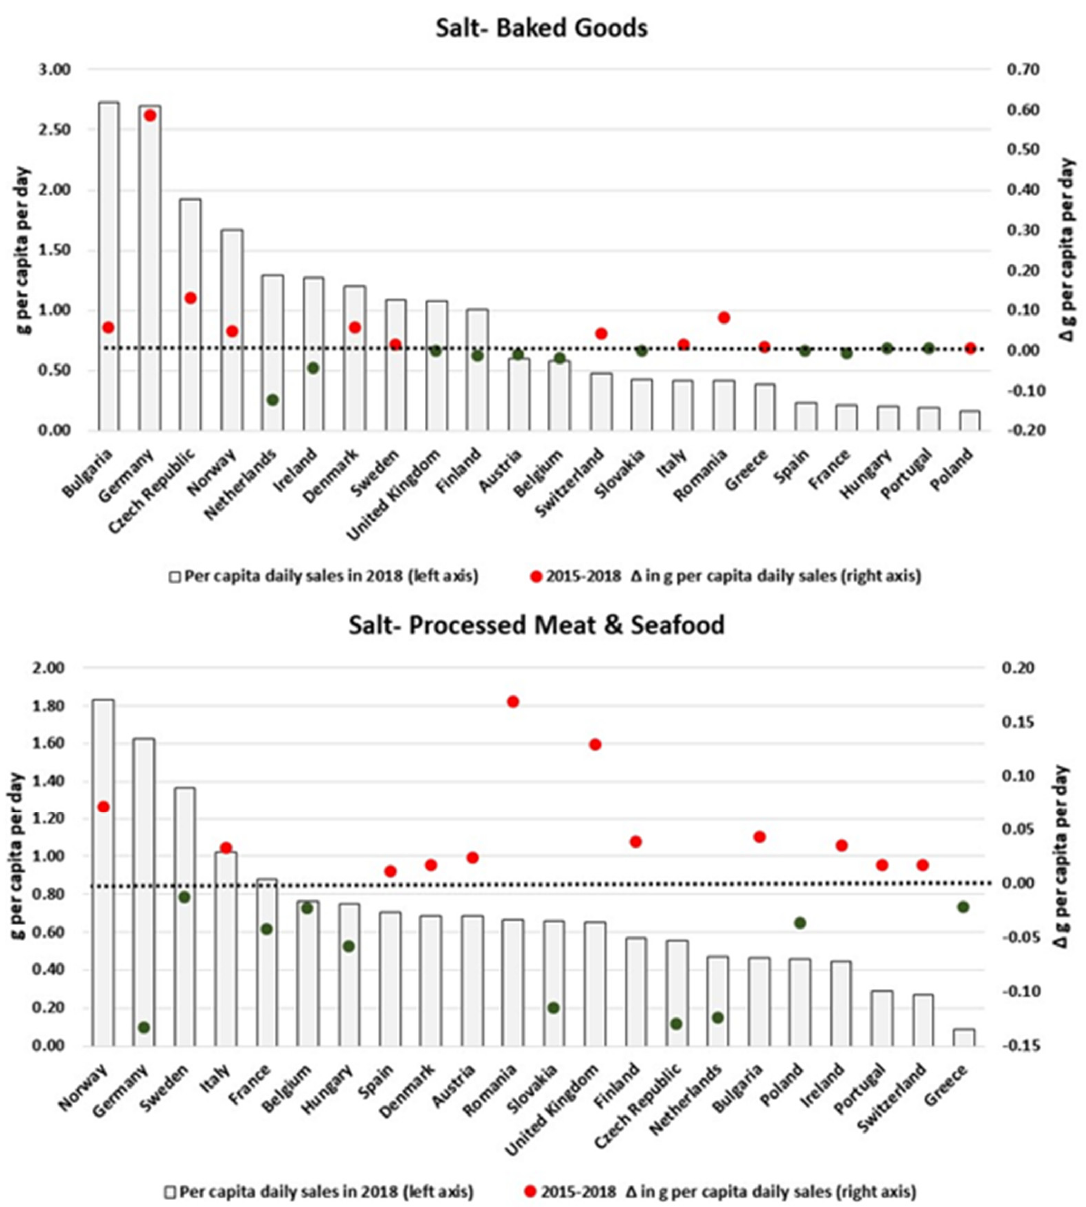
Figure 7. Estimates of salt sold through Baked Goods and Processed M & S in 2018 and the respective 2015–2018 variation (in g/pc/day). Source: Elaborated by the authors based on data from Euromonitor (2020) and mid-year population estimates from the HFA-DB. Estimates were scaled by market coverage to represent 100% of the retail market. The right-hand axis represents the nutrient variation in g per capita per day (green for negative values, red for positive values), and the dotted black line indicates the variation of 0 g per capita per day as a reference.